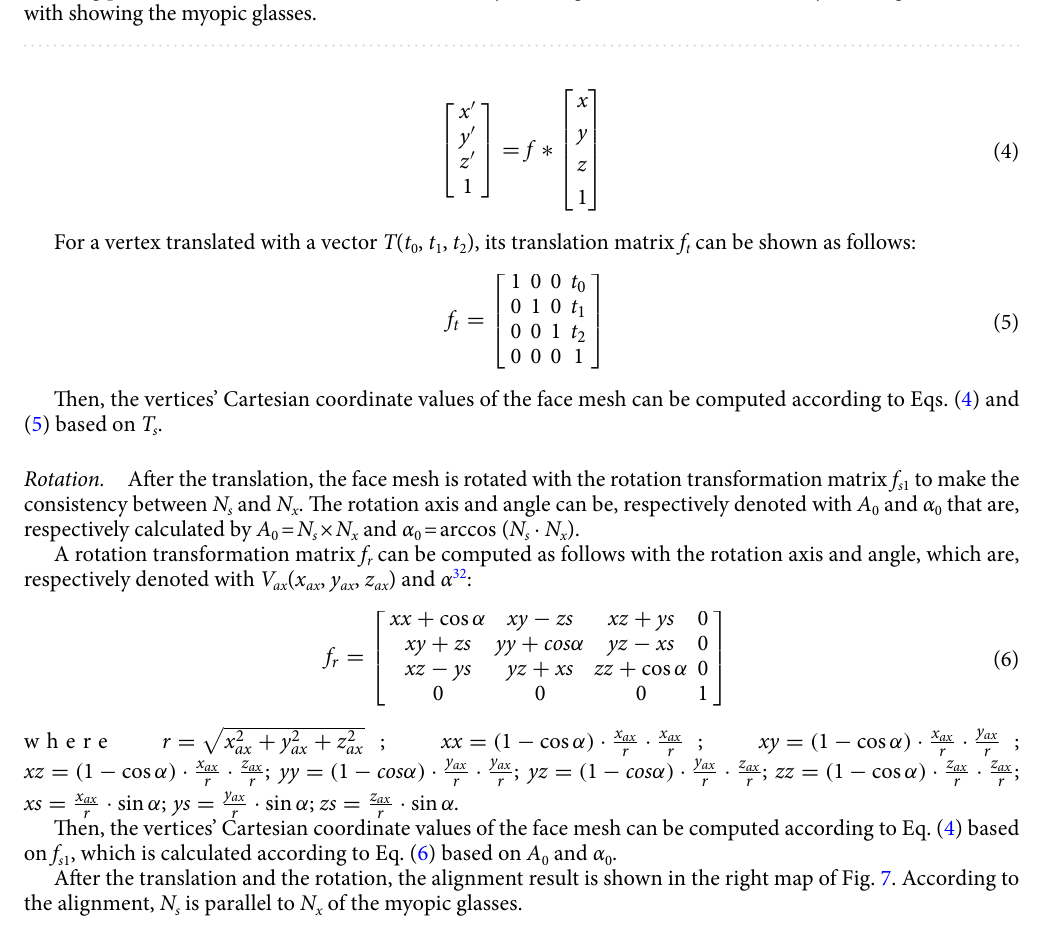
Figure 8. Coordinate system alignment. From left to right: silent point extraction of the eye with blue sphere, referring plane defined with red normal, coordinate system alignment result, coordinate system alignment result with showing the myopic